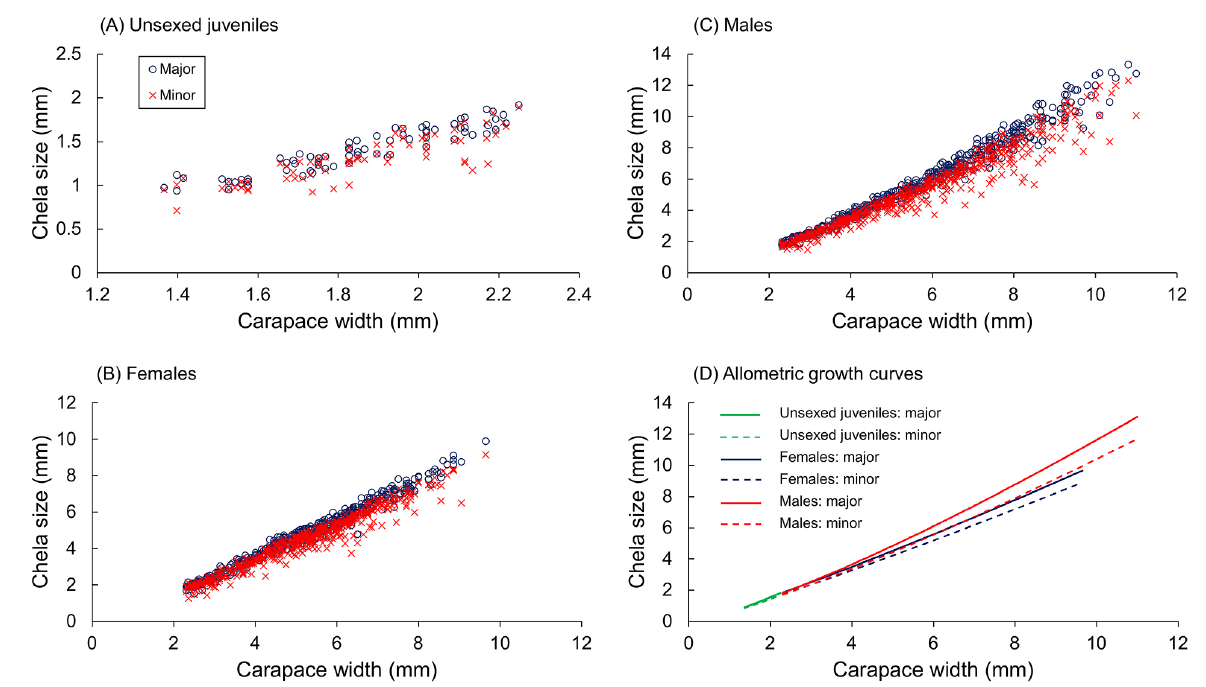
Figure 4. Growth of the chela size (geometric mean of the propodus length and width) of the major and minor chelipeds relative to the carapace width in unsexed juveniles (A) , females (B) and males (C) of the porcellanid crab Petrolisthes japonicus . Allometric growth curves derived from the log-transformed regression equations of major and minor chelipeds (Tab. 2) are shown for the respective groups (D) . Table 2. Coefficient estimates with standard errors (SE) and their 95 % confidence intervals (CI) of log-transformed allometric growth equations (lnChS + ln a = b lnCW) to evaluate the relationships between carapace width (CW) and chela size (ChS, geometric mean of the propodus length and width) of major or minor chelipeds of the porcellanid crab Petrolisthes japonicus . The statistical significance of the coefficient estimates and each model was evaluated with t -tests and F -tests,